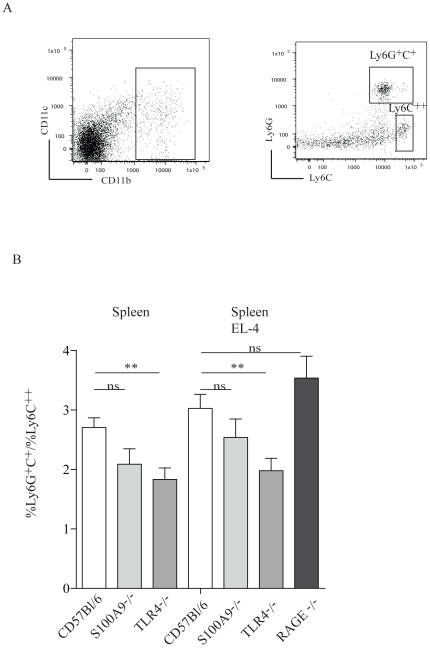
The CD11b+Ly6G+Ly6C+ cell population is reduced in spleens from S100A9−/− and TLR4−/− animals.FACS analysis of spleen cells from C57BL/6, S100A9−/−, TLR4−/− and RAGE−/− animals. Panel A: Left: The gate used for defining CD11b+ cells is shown. Right: The Ly6C/Ly6G populations used for comparison and defined as indicated. Panel B: The ratio of CD11b+Ly6G+C+/CD11b+Ly6C++ cells in the different mouse strains in the presence and absence of subcutaneous EL4 tumor, as indicated. Statistical analysis using two-tailed t test ** p = 0.0034.